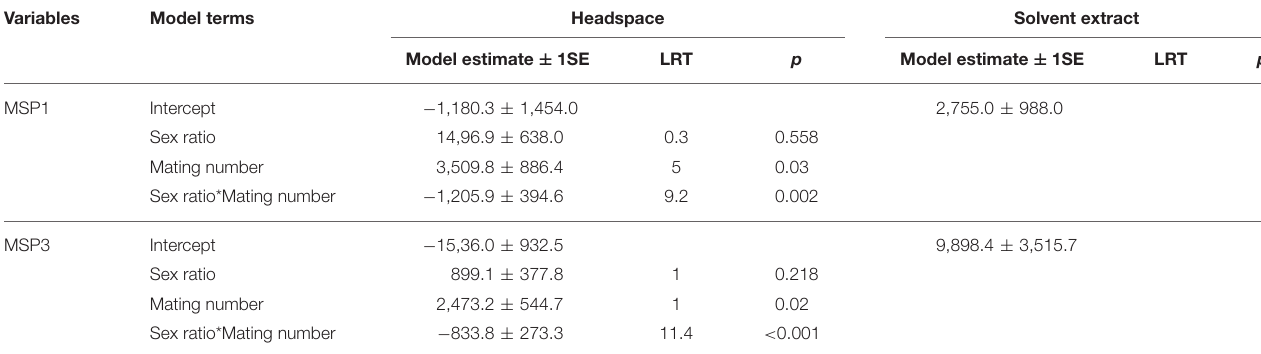
TABLE 2 | Summary of models testing for the effects of sex ratio and mating number on MSP1, and MSP3, where male and female age were used as a random factors.